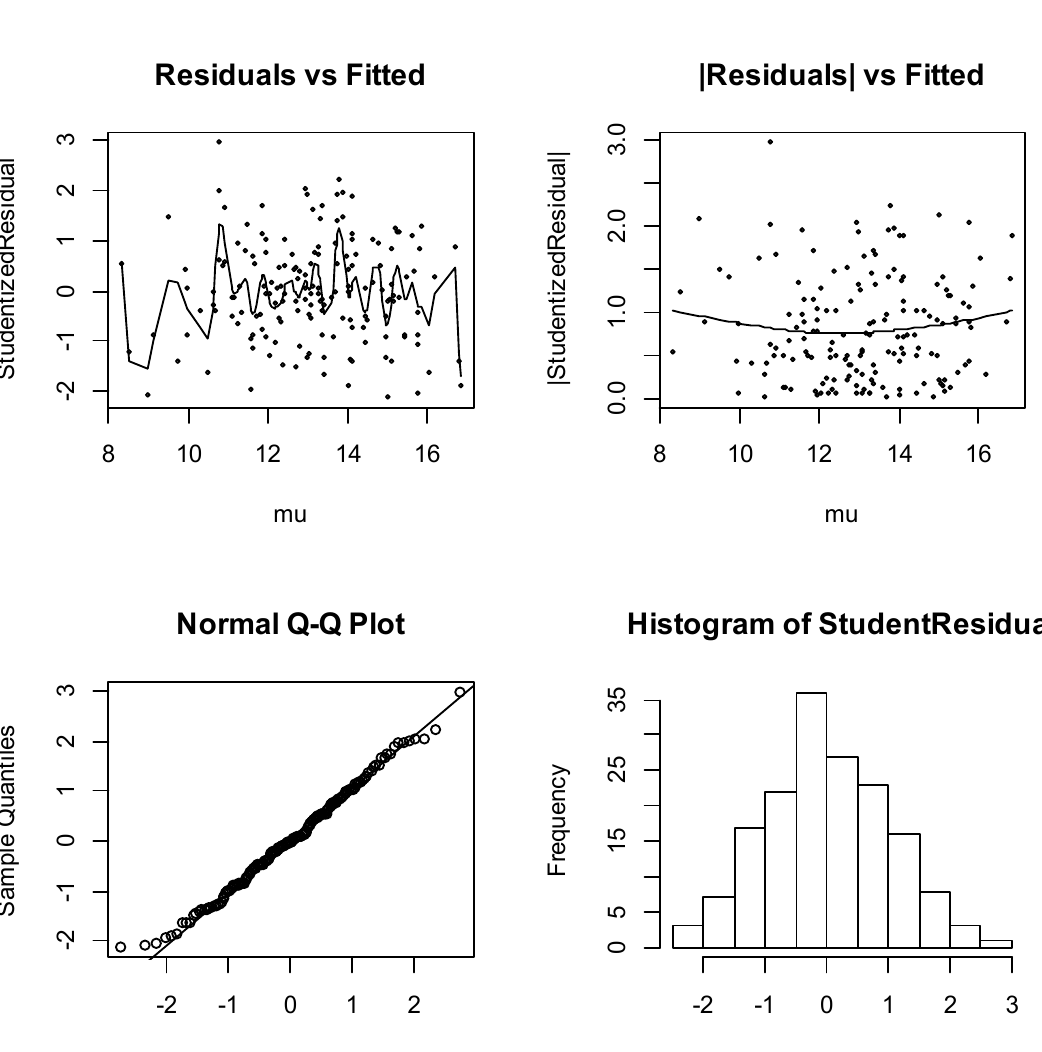
Figure 3. Diagnostic plots for joint Gaussian GLM.